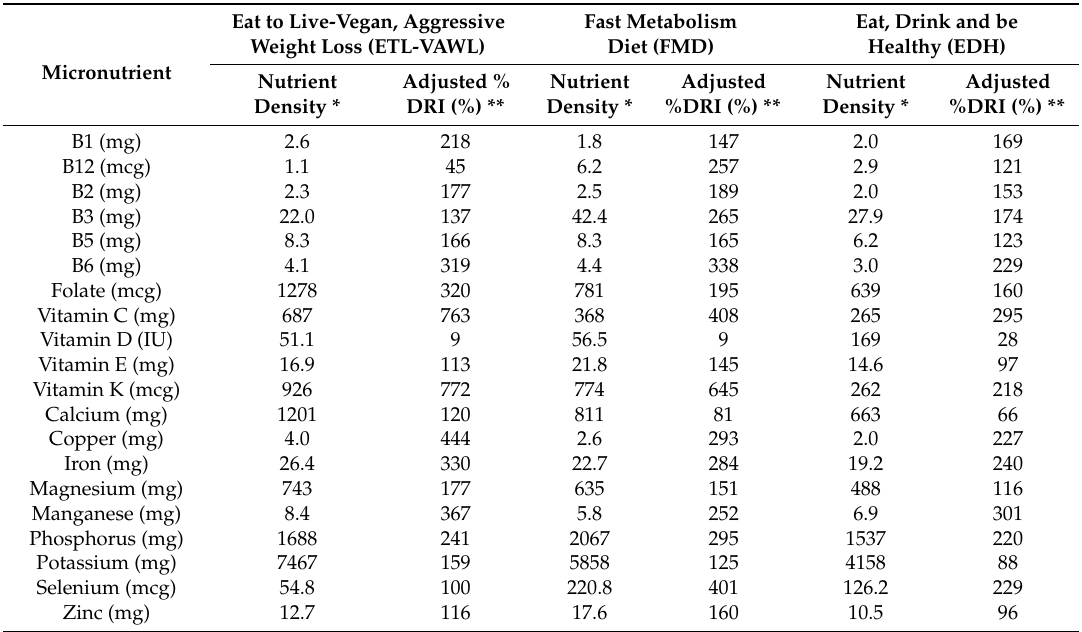
Table 4. Nutrient density * (per 2000 calories) in three weight-loss diet plans compared to Dietary Reference Intake (DRI) values for U.S male